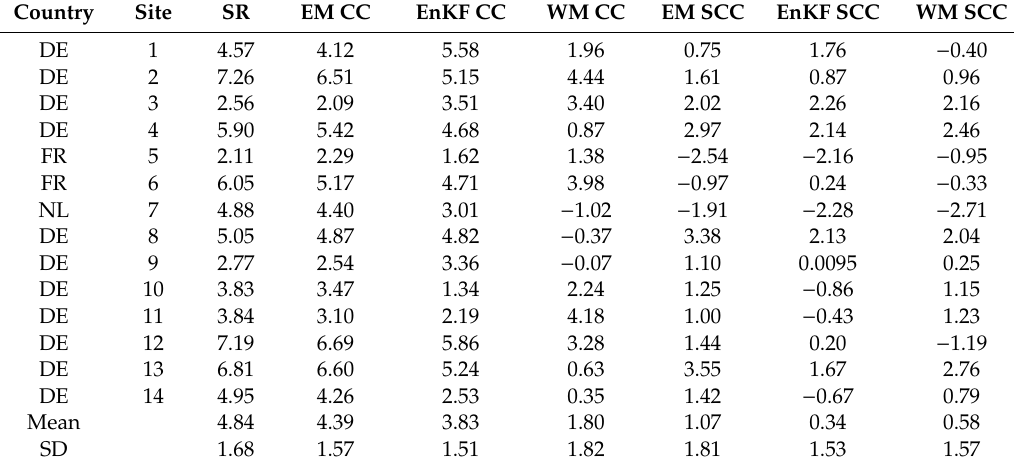
Table 7. Bias results for total aboveground biomass per site. SR: Standard Run, EnKF: Ensemble Kalman Filter, WM: Weighted Mean, EM: Ensemble Mean, CC: Crop Component Set, SCC: Soil and Crop Component Set. All values in t ha − 1 . Positive values indicate overestimation of the model, negative values indicate underestimation. DE: Germany, FR: France, NL: